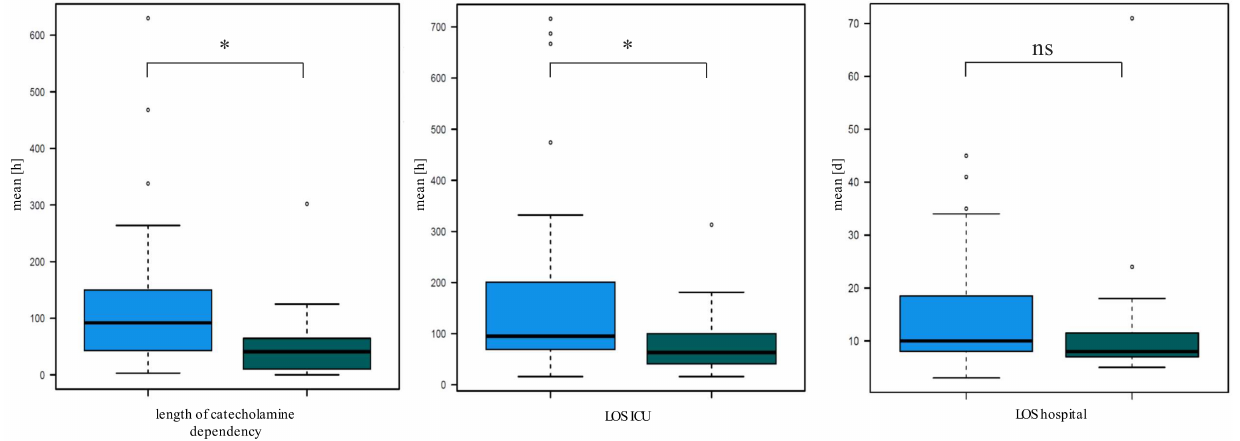
Figure 6. Duration of catecholamine dependency ( p < 0.001), duration of intensive care therapy ( p < 0.001), and length of hospital stay ( p = 0.095) in delayed extubation DET group (blue bars) and on-table extubation OTE group (green bars) after propensity score matching, n.s. not significant, * p <